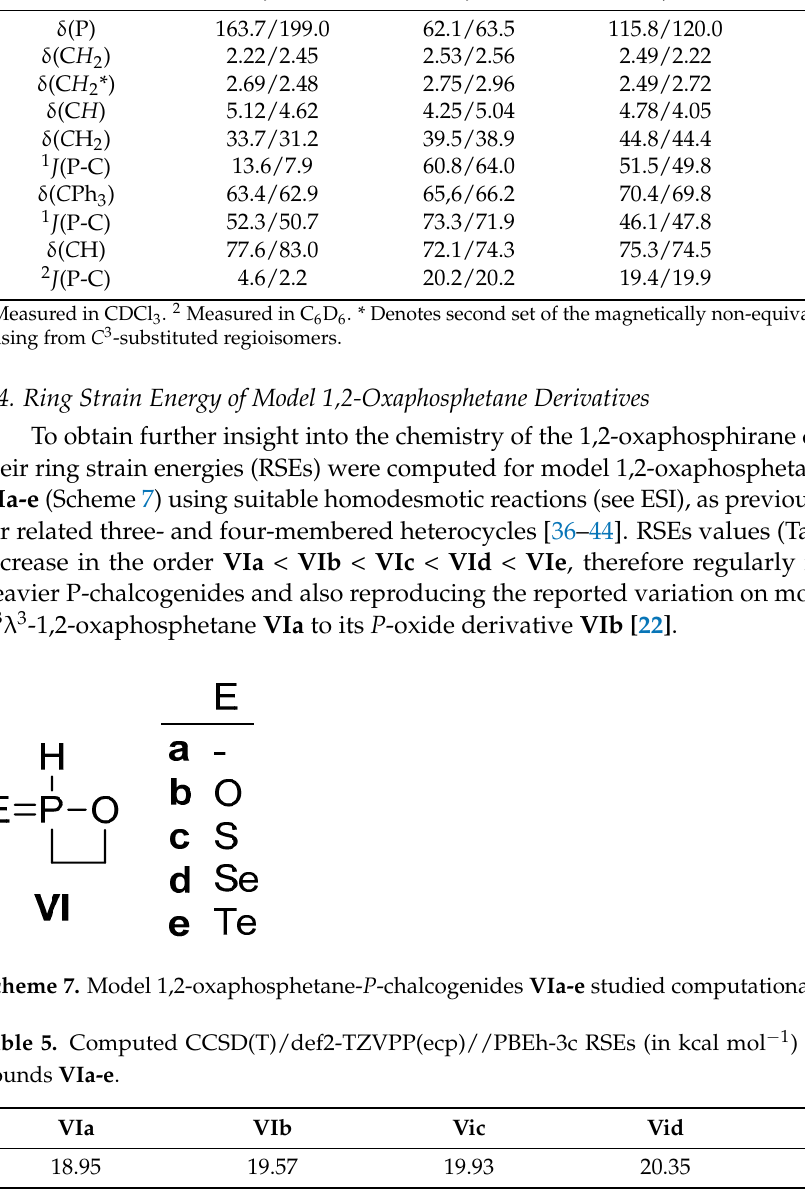
Table 4. Selected NMR spectroscopical data of 4a,a’ , 14a,a’ , 15a,a’, and 16a,a’ , chemical shifts in ppm, and coupling constants in Hz. See Supplementary Materials for more data and spectra.